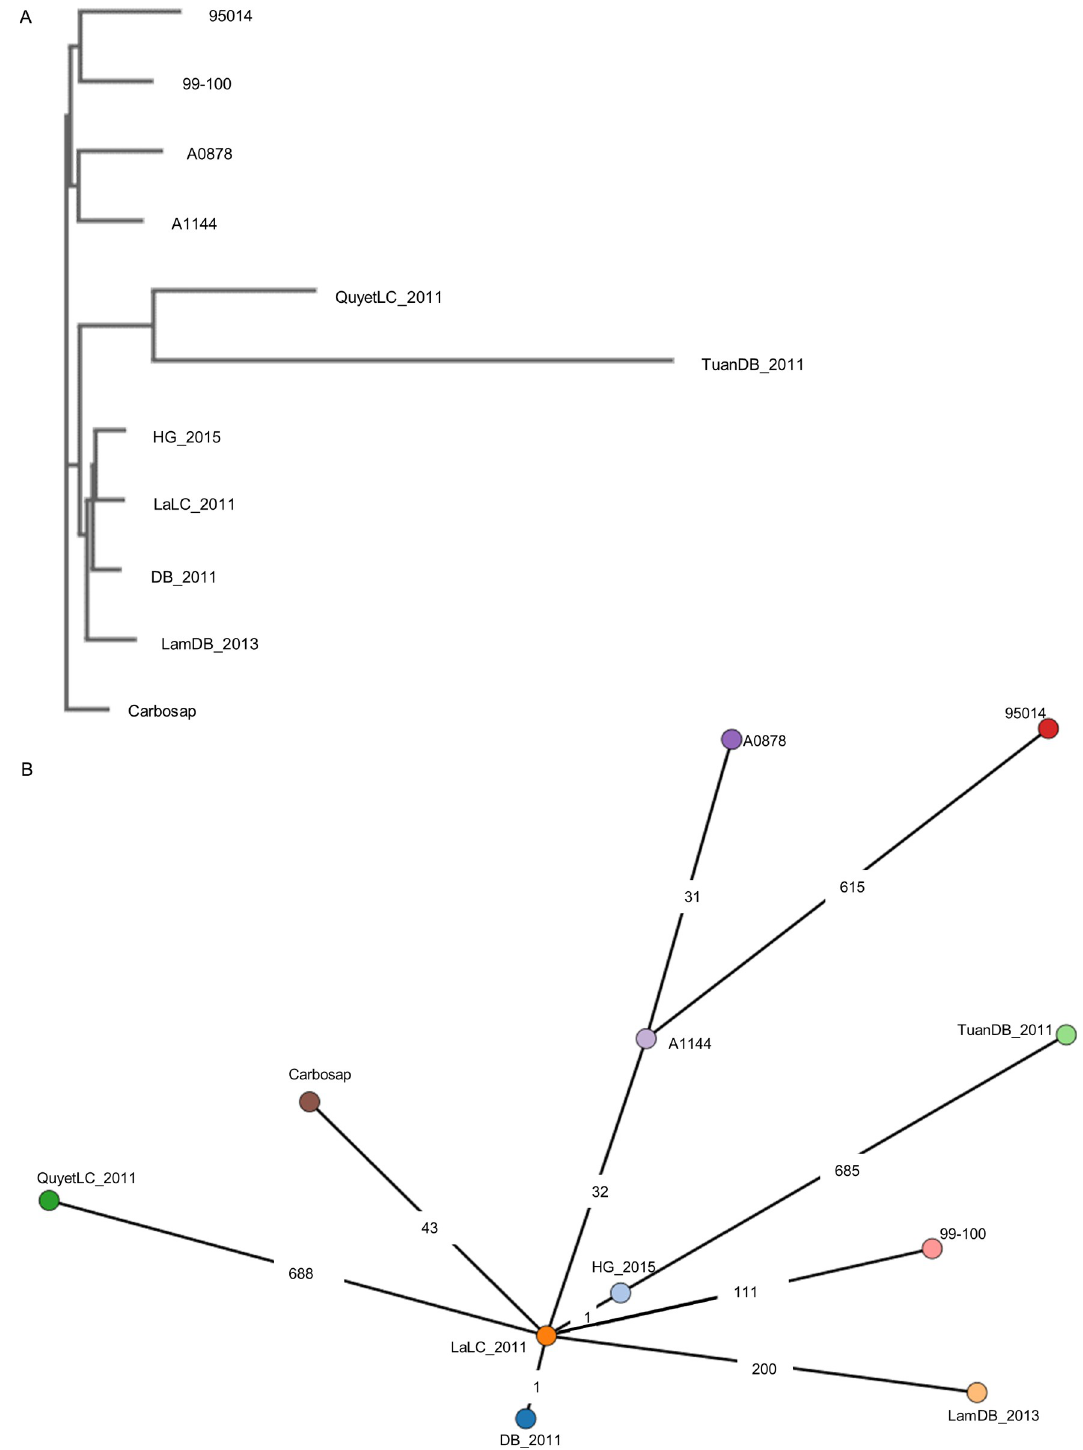
Fig 4. Multiple genome analysis was used to determine the phylogenetic relatedness among the genome sequences of TEA group strains following both SNP and whole-genome MLST approaches using tools in BacWGSTdb. (A) The phylogenetic tree based on the SNP strategy from the assembled contigs of six Vietnamese strains and five genetically closest TEA group strains (Carbosap, A0878, 95014, A1144, and ANSES_99–100) was visualized using the neighbor joining method. (B) Minimum spanning tree based on the whole-genome MLST strategy encompassing not only core genome genes/loci but also accessory genes/loci was visualized with static redraw and log scale modes. The numbers on the branches indicate the number of SNPs between strains.